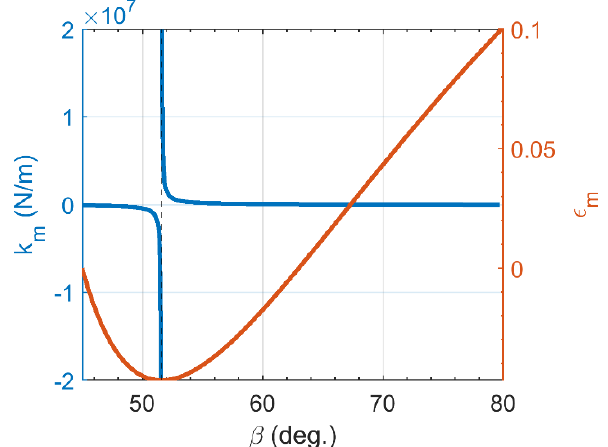
Figure 16. Realized negative muscle stiffness behavior for bipennate muscle bundles with fiber contact boundary condition. The blue profile illustrates a variation in muscle stiffness during fiber actuation, and the orange profile corresponds to a change in muscle strain during fiber actuation.